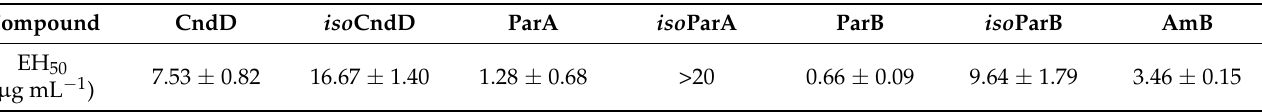
Table 3. Hemolytic activity of Candicidin D (CndD), Partricin A (ParA), Partricin B (ParB), their all-trans isomers iso CndD, iso ParA, iso ParB and Amphotericin B (AmB). EH 90 (erythrocyte hemolysis) values were determined under conditions described in 4.4. Each value is a mean of three independent determinations ± SD.